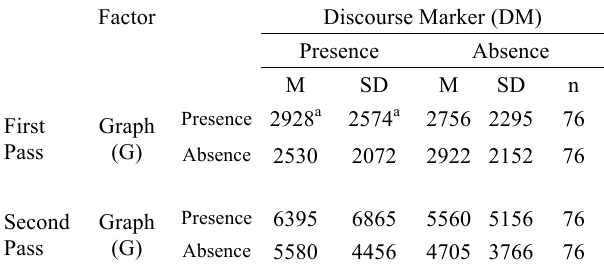
Table 4. Mean and Standard Deviation for First Pass and Second Pass on the cause segment (S1).